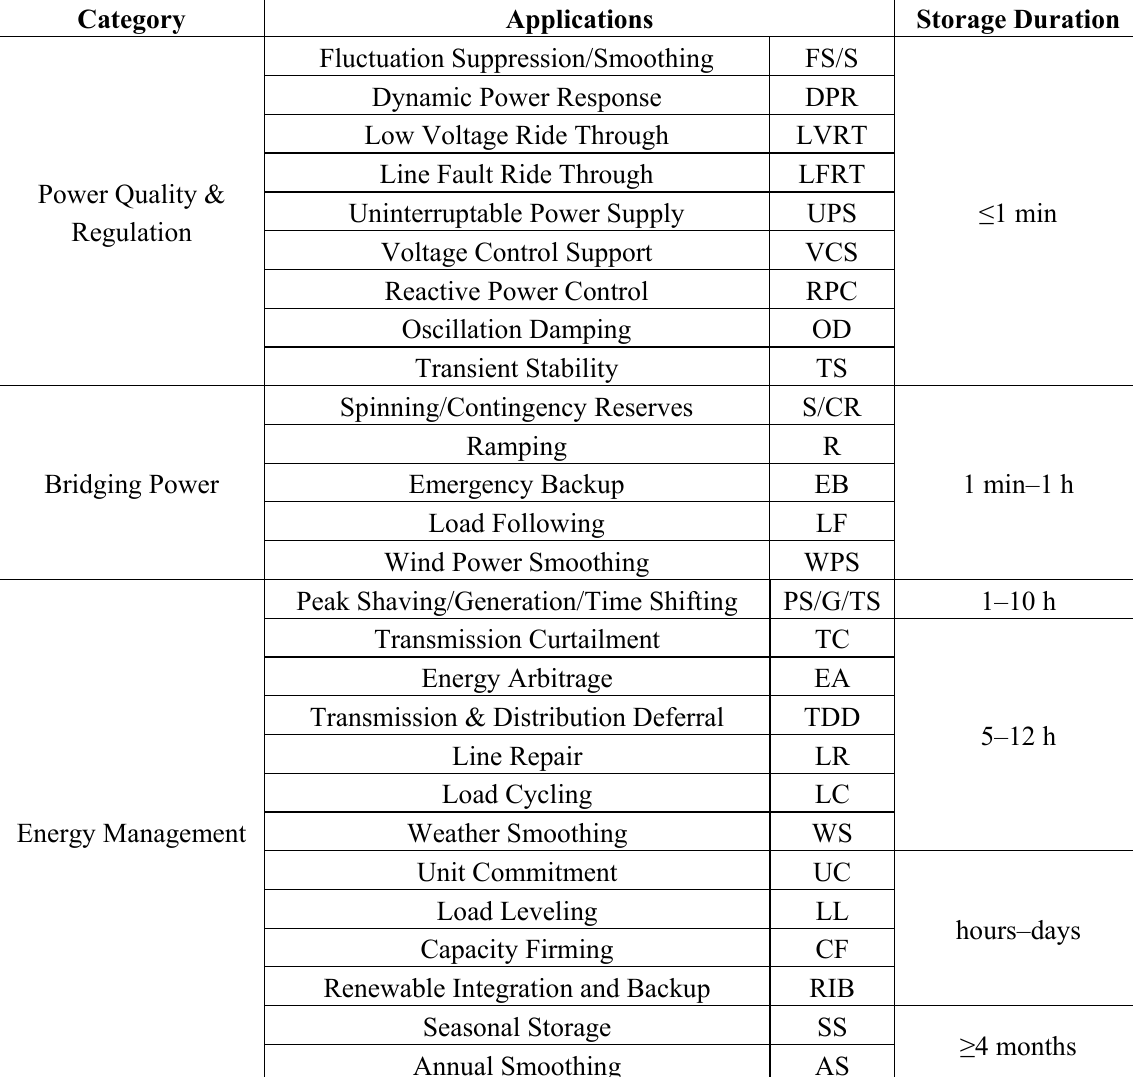
Table 2. Typical applications of energy storage based on storage duration. Data obtained from multiple sources